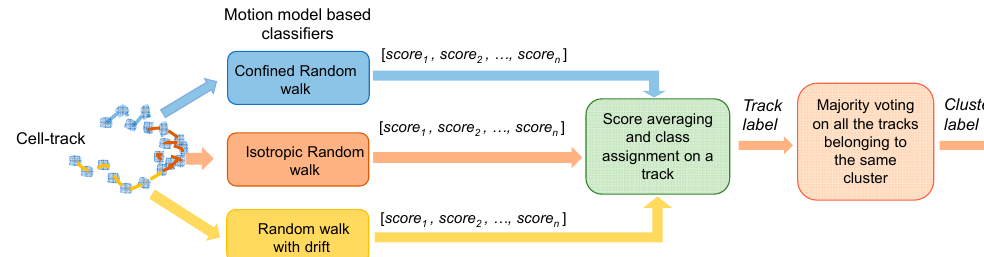
Figure 4. A Schematic block-diagram of the proposed classification platform. From left to right: three classifiers related to the three types of motion are built in order to execute classification on sub-tracks attributed to each kind of these motion models. Each classification model should be able to return a score to belong to a given of n classes (Score 1 , Score 2 , and Score n ). The score can be averaged class by class, and then the label corresponding to the highest score is assigned to the track (i.e., Track label). The majority voting procedure is then performed at the cell track level, and a label is finally assigned to the entire cluster (i.e., Cluster label).